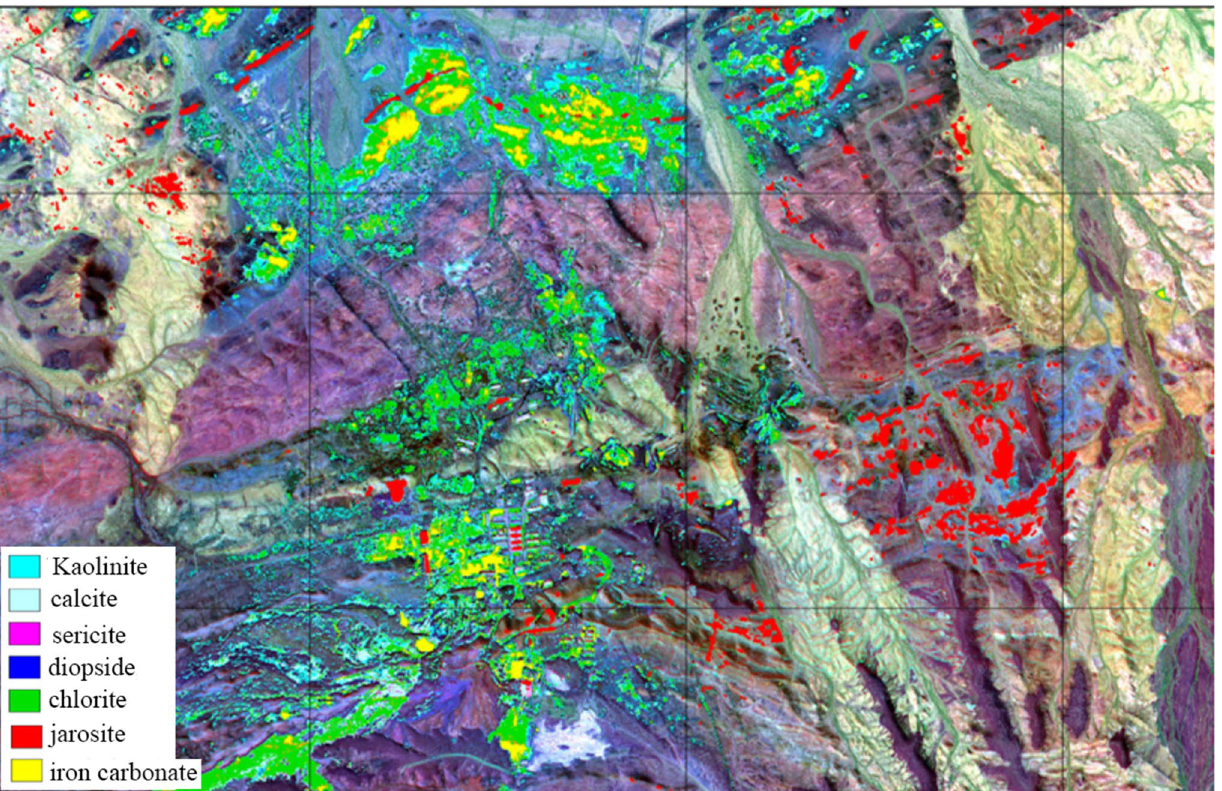
Figure 3. Piece of MTMF results. This figure is generated by Yu-Qing Wan, using ENVI (version4.3) created by the ENVI Team under an open license (http://www.envii